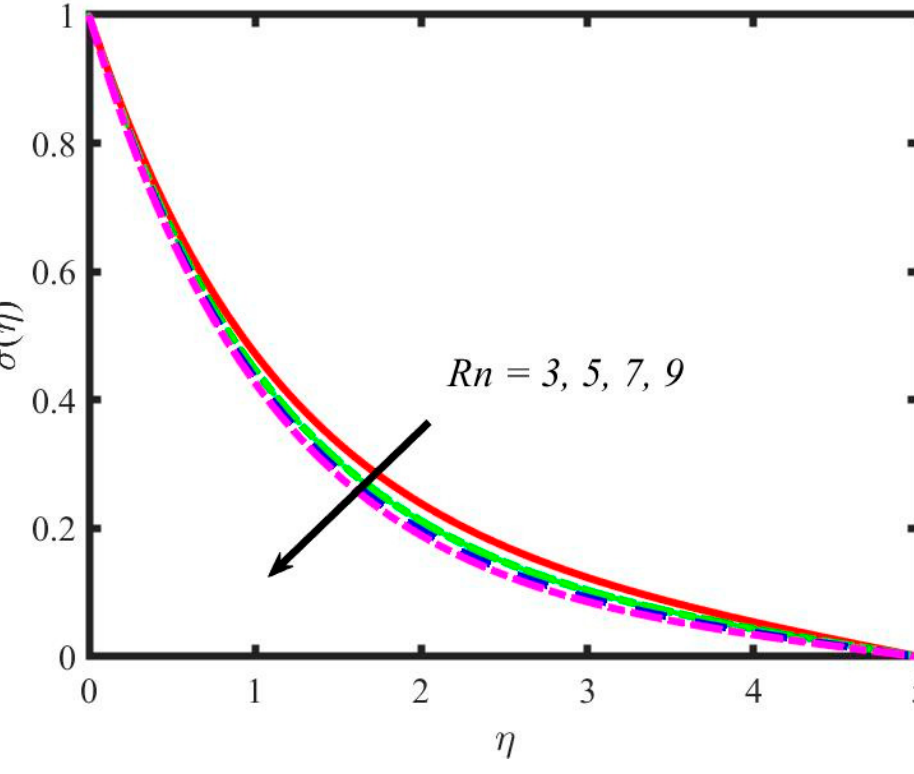
Figure 16. Variations in nanoparticle concentration for radiation parameter.